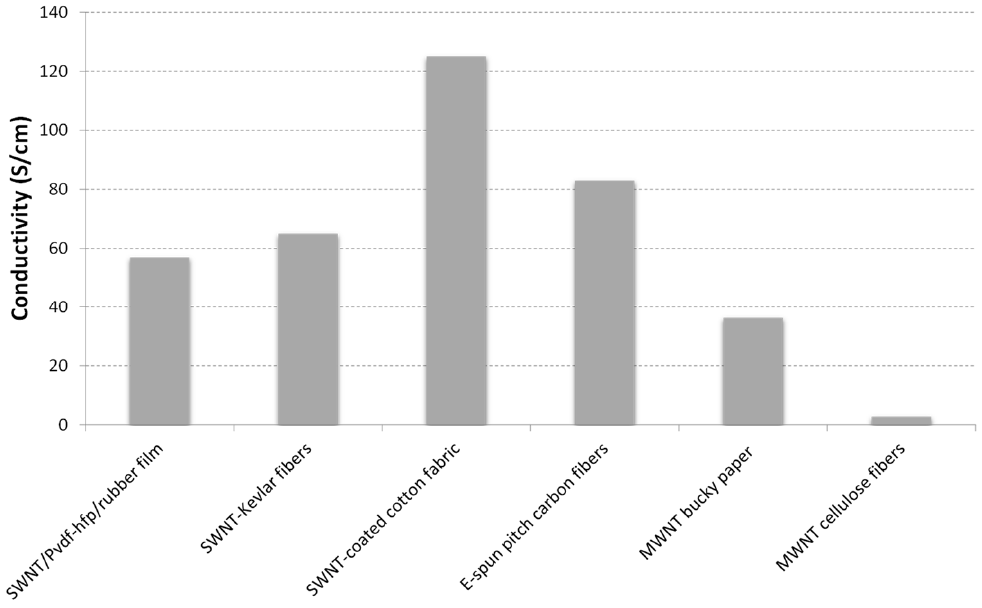
Figure 10. example conductivity levels of carbon-based materials reported in the literature. Figure 10. Example conductivity levels of carbon-based materials reported in the